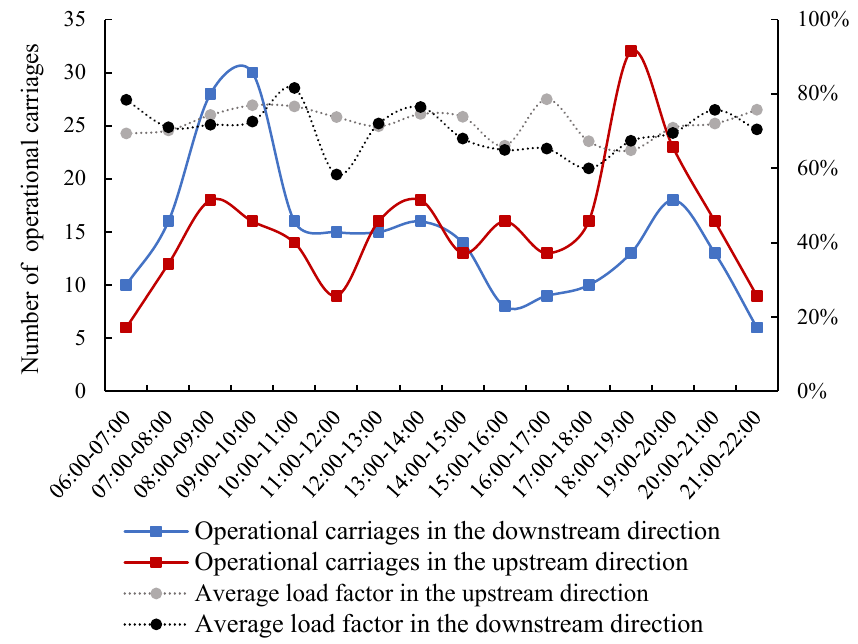
Figure 8. The number of operational carriages and average load factor at each time period.